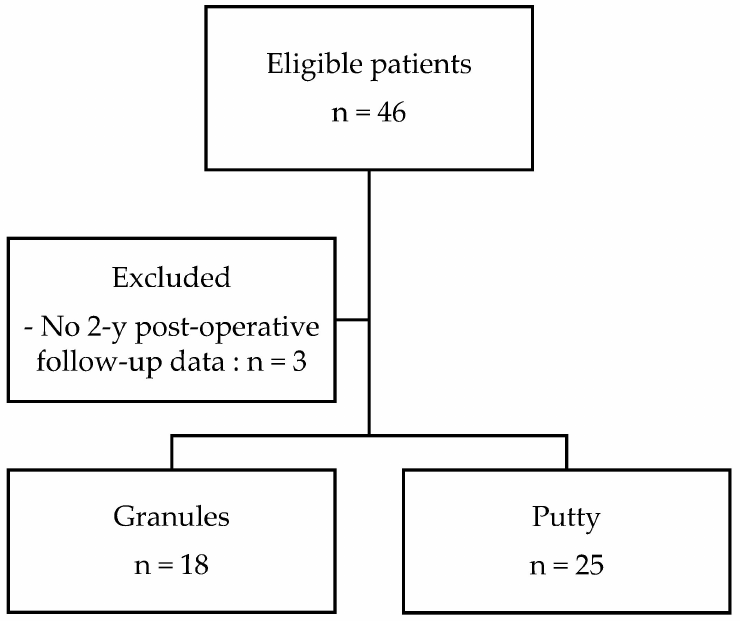
Figure 2. Flowchart of the